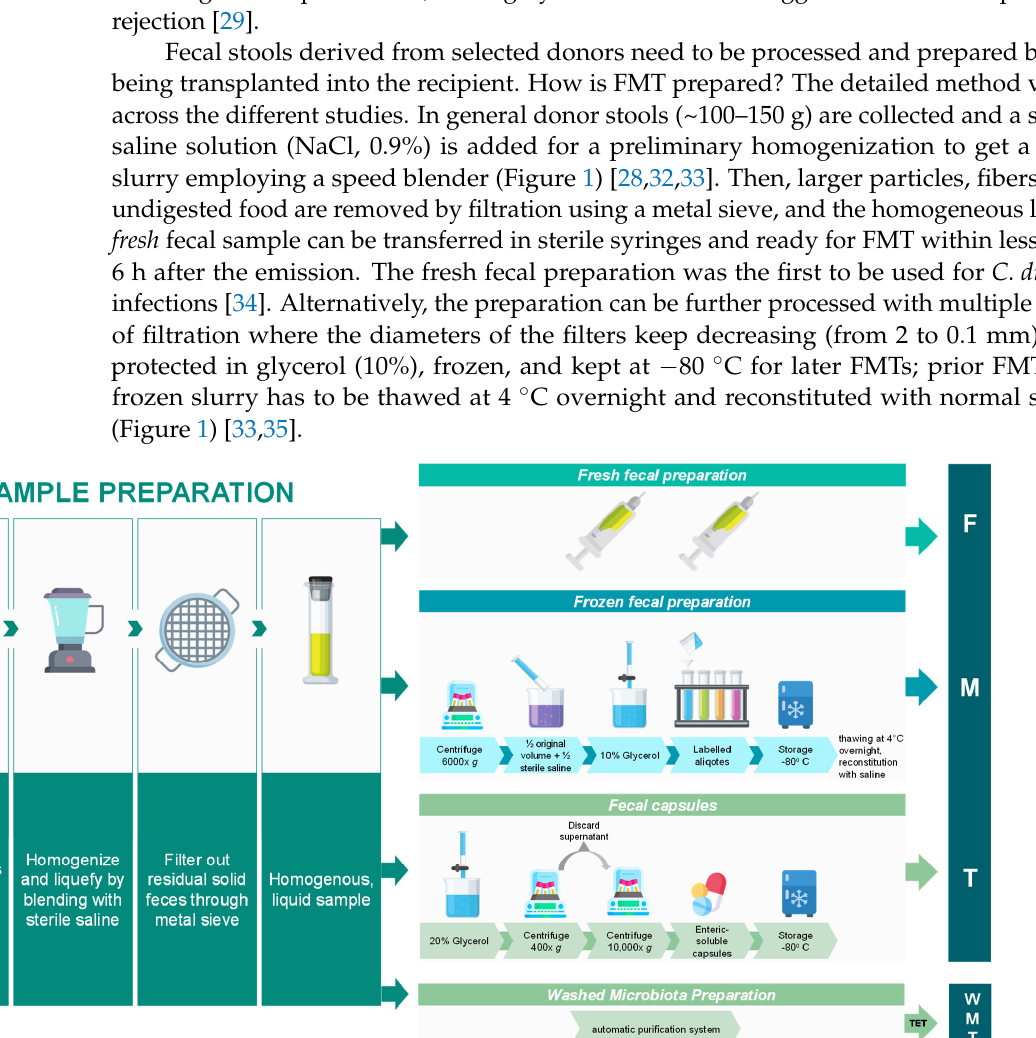
treatment in severe or complicated C. difficile infection, though this protocol requires a trained endoscopist, it is costly, and it carries procedural risks; it cannot be performed in subjects with colon inflammation. Different from the classic enema or colonoscopy, co- lonic transendoscopic enteral tubing (TET) involves the placement of a tube through the anus into the cecum for whole-colon administration (Figure 2). The tube could be main- tained for repeated FMTs. TET showed to be effective and less psychologically chal-